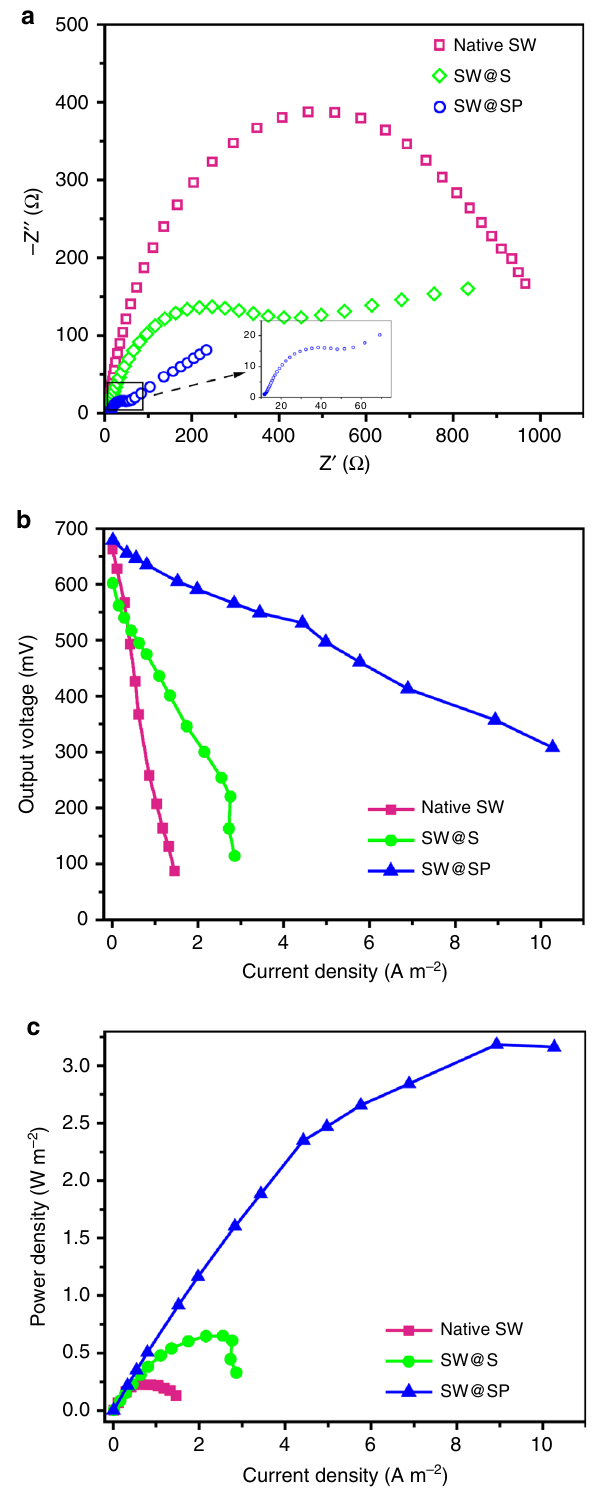
Fig. 6 Performance of BES inoculated with different cells. a – c EIS spectra, polarization curves and power output curves of MFCs with different The individual cell electron transfer ef fi ciency (rate and recovery) is the most essential parameter that determines the performance of living cell electronics. As the single cell in situ electron collectors developed here can wire up more transmembrane electron conduits and establish new